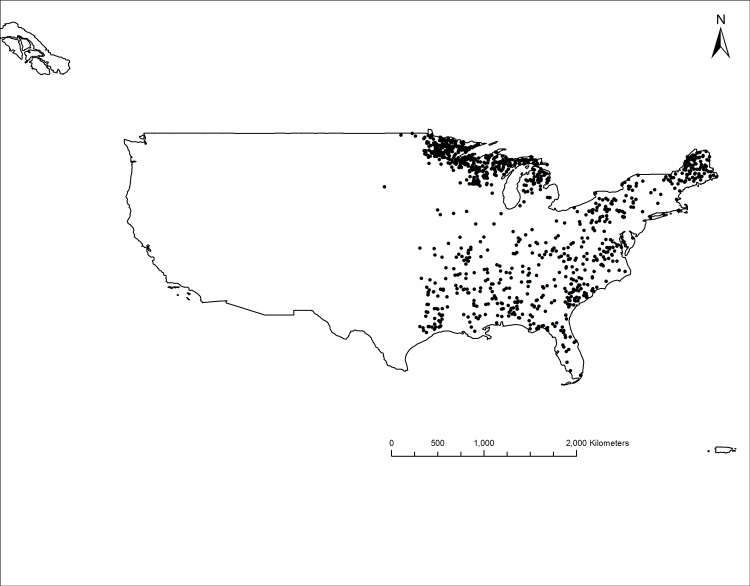
Approximate location of the sample plots in the eastern United States.